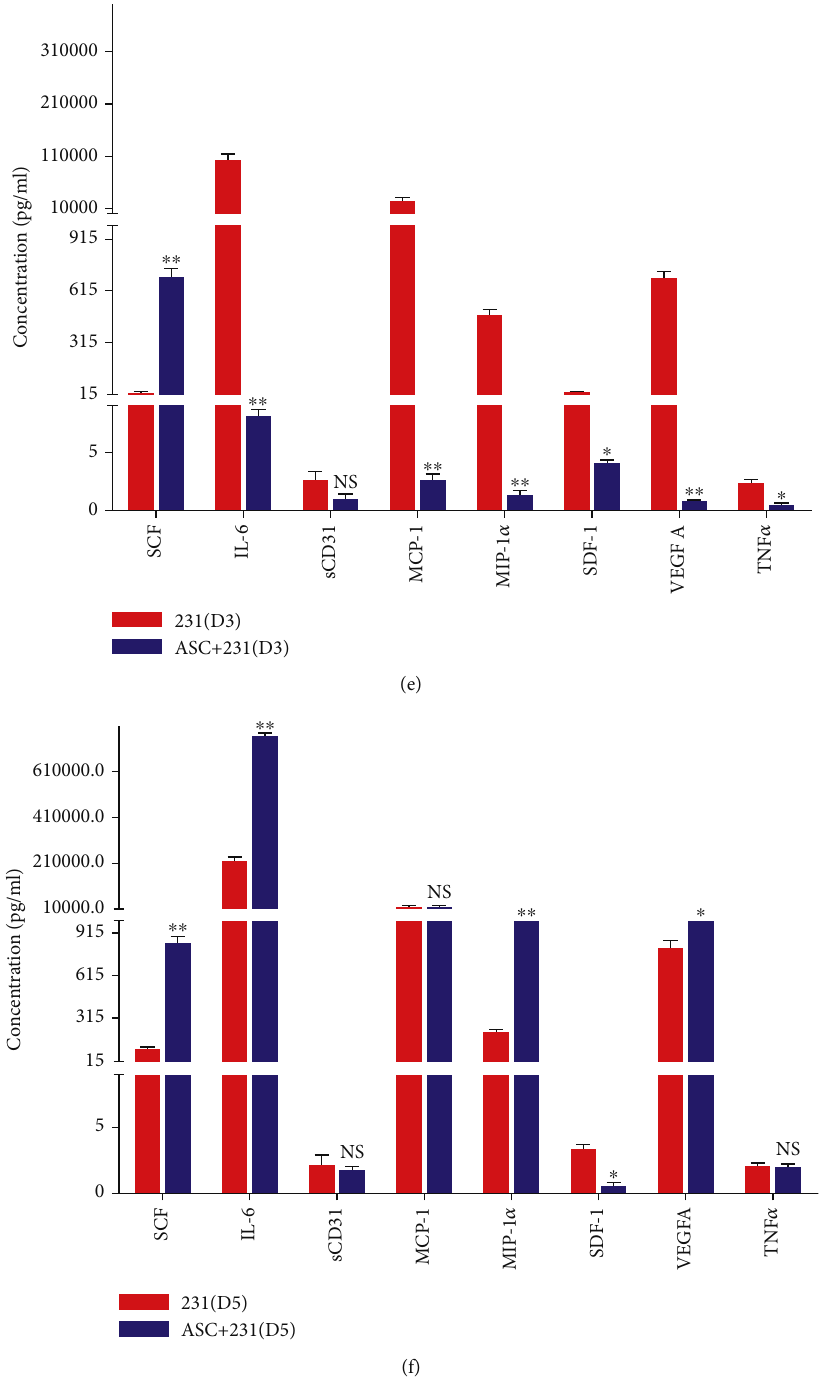
Figure 1: ASCs promote the viability, proliferation, and colony formation of breast cancer cells following the release of cytokines and chemokines. (a – c) Cell viability, proliferation, and colony formation were analyzed using CCK-8 assays, dsDNA quanti fi cation, and colony formation assays in MDA-MB-231 cells treated with culture supernatant from ASCs. (d – f) The release of cytokines and chemokines including SCF, IL-6, sCD31, MCP-1, MIP-1 α , SDF-1, VEGFA, and TNF α in MDA-MB-231 cells cocultured with ASCs was analyzed using Milliplex MAP kit. ∗ P < 0 : 05 , ∗∗ P < 0 : 01 , ∗∗∗ P < 0 : 001 ; NS: no signi fi